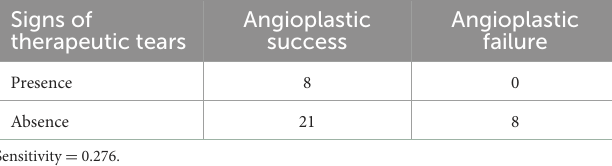
TABLE 7 Predictive value of the signs of “therapeutic